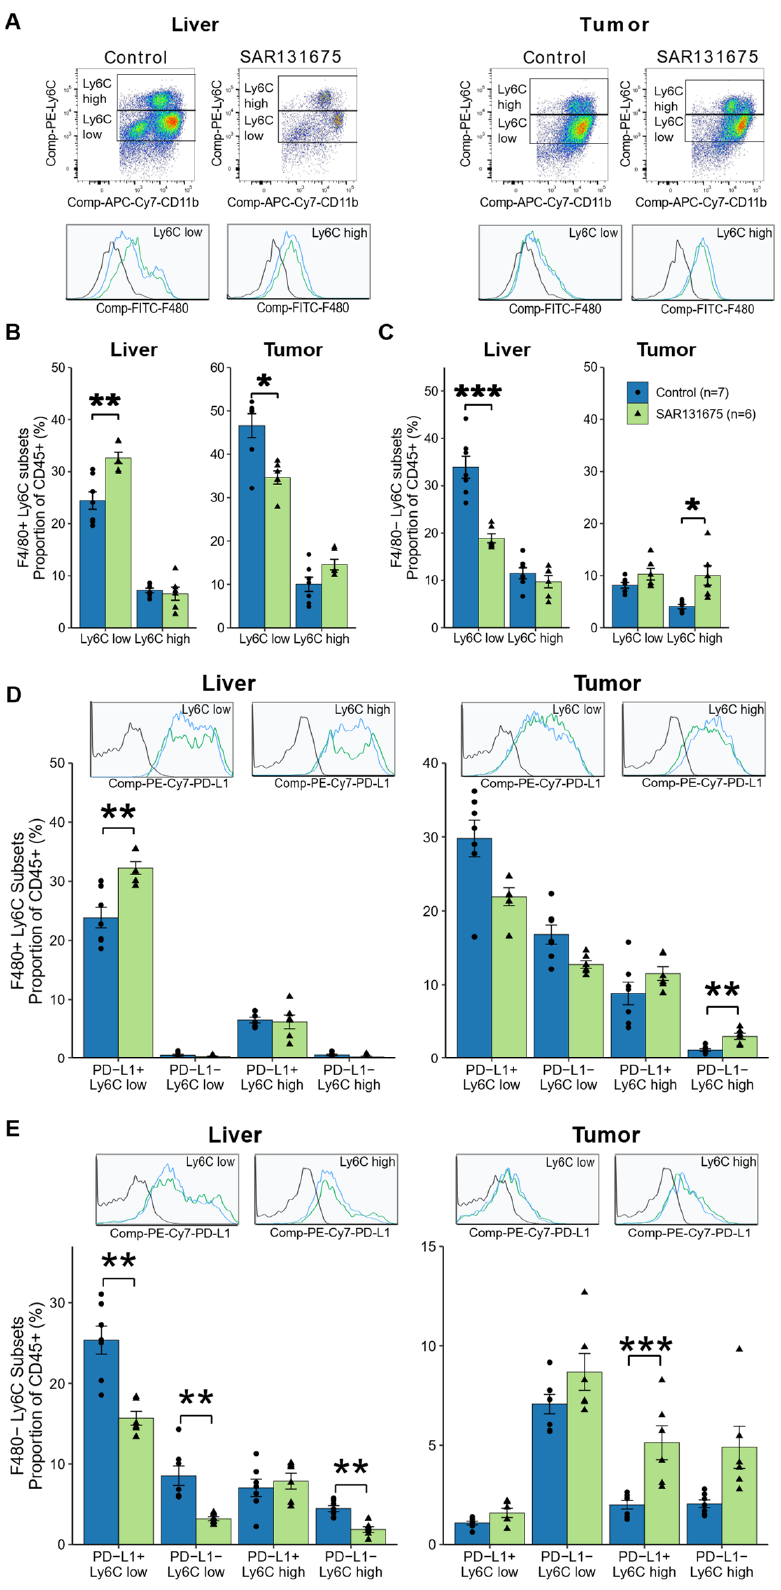
Figure 6. SAR131675 treatment alters the phenotype of myeloid cells in liver and tumor at day 22. Myeloid cells were defined as MDSC (F4/80 − ) or macrophage (F4/80 + ) while high and low expression on these subsets of Ly6C defined these as monocytic and granulocytic, respectively. ( A ) Representa- tive dot plots of CD45 + CD11b + cells and histograms of F4/80 fluorescence in Ly6C low and Ly6C high expression populations in liver and tumor. ( B ) Percentage of Ly6C low and Ly6C high macro- phages and ( C ) MDSC. ( D ) Representative histograms of PD-L1 fluorescence in Ly6C low and high expression populations of F4/80 + macrophages and percentage of PD-L1 + and PD-L1 − in these pop- ulations as a proportion of CD45 + leukocytes ( E ) Representative histograms of PD-L1 fluorescence